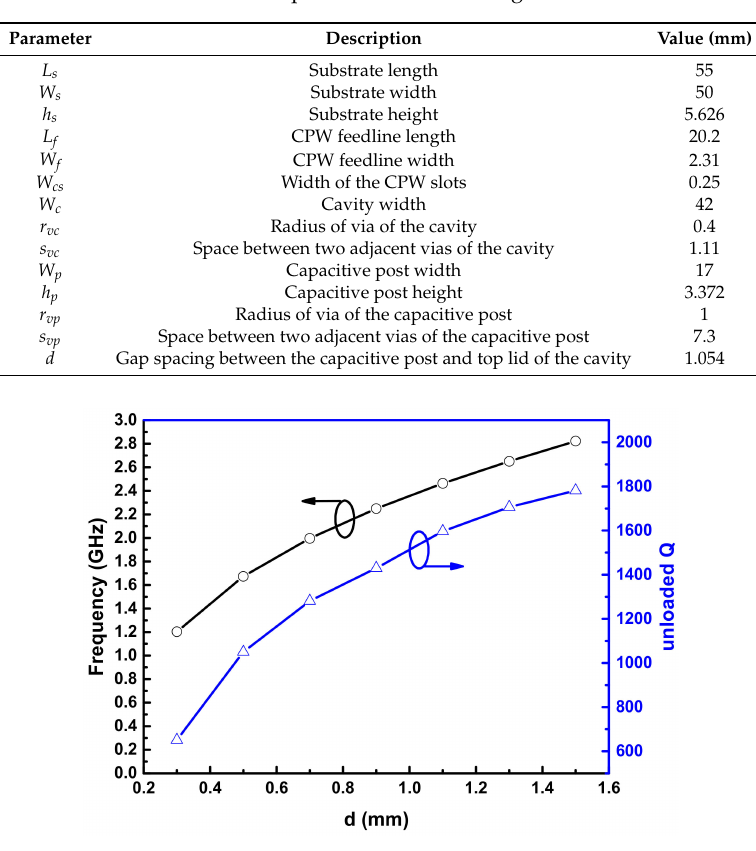
Figure 4. Simulated resonance frequency and unloaded Q-factor of the designed resonator versus gap spacing d